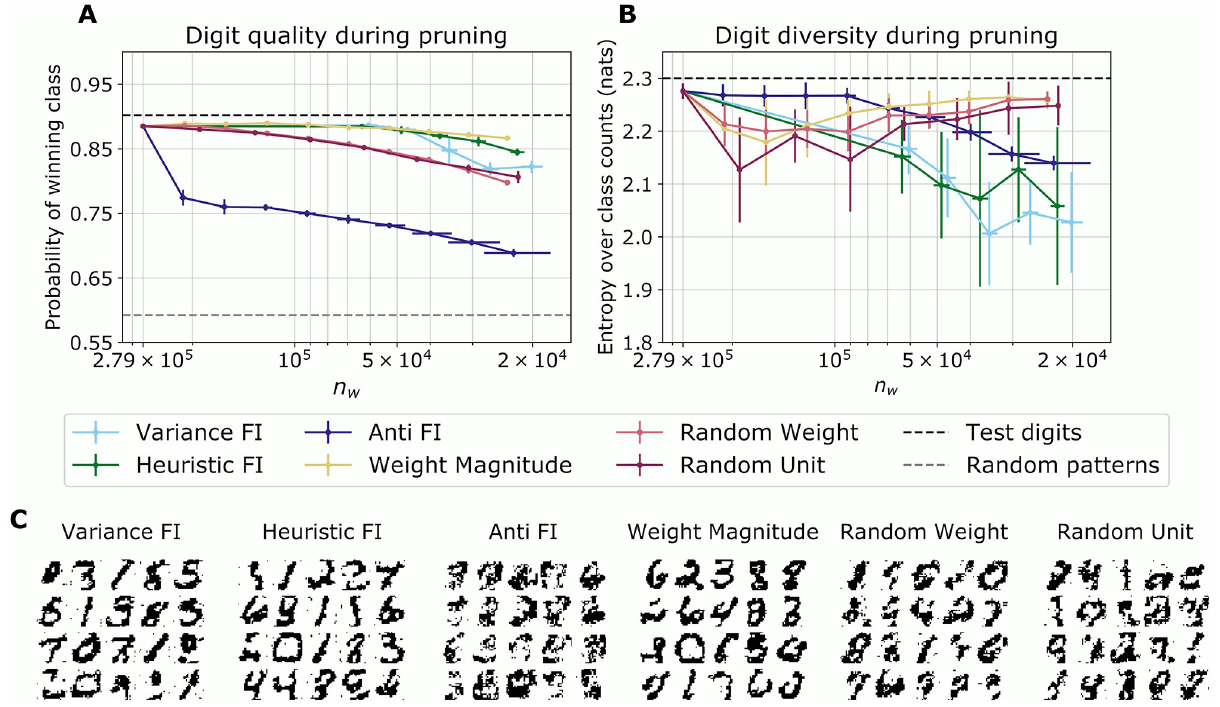
Fig 4. Generative performance during pruning. (A) Maximum class probability assigned to generated samples from pruned networks averaged over 10 runs. This summarizes the confidence of a classifier that the generated digits belonged to a specific class. Error bars denote standard deviations. The black and gray dashed line show the confidence of the classifier for the MNIST test digits and randomly generated patterns, respectively. (B) Entropy over the distribution of generated digits. An entropy value of � 2.30 nats corresponds to even coverage of all digits, which is achieved by the test digits (dotted line). All data points are averages from 10 independent simulations, and error bars denote one standard deviation. (C) Examples of generated patterns after pruning completed.